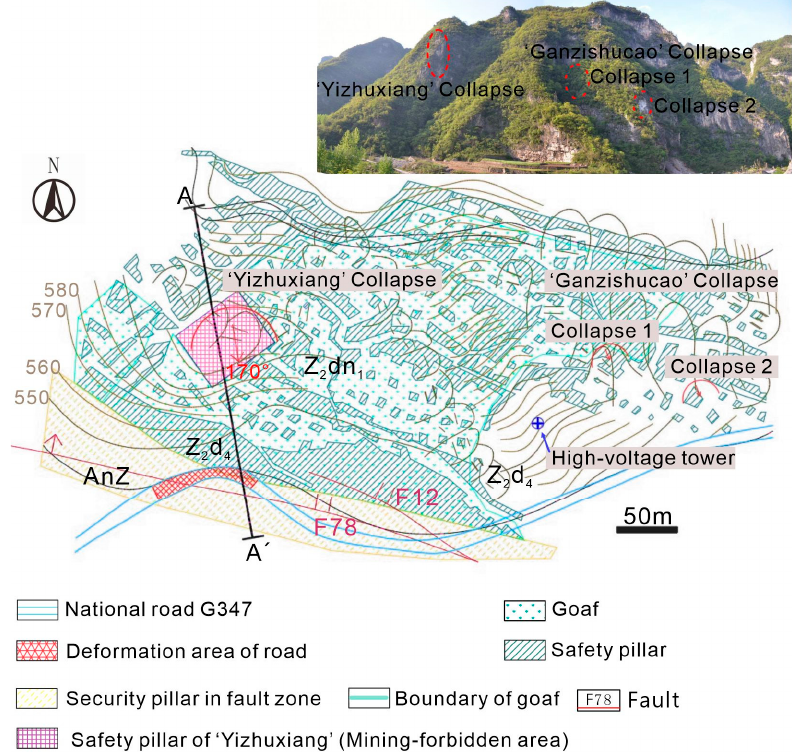
Figure 4. Floor plan of the goaf in the studied area.